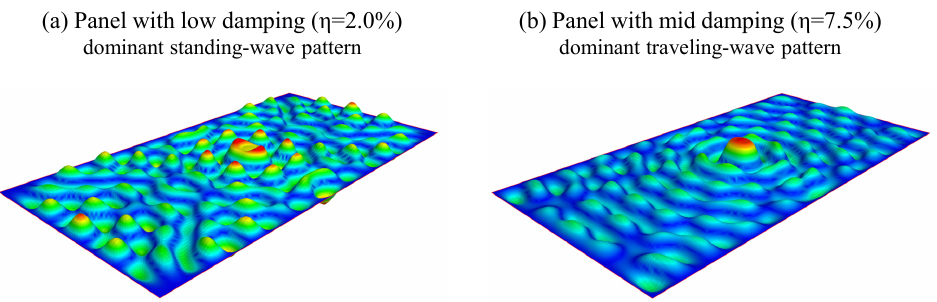
Figure 7. HPL panel with different damping loss factors showing an overlay of standing and traveling wave patterns: ( a ) represents a panel with a low damping loss factor; and ( b ) represents a panel with a mid-damping loss